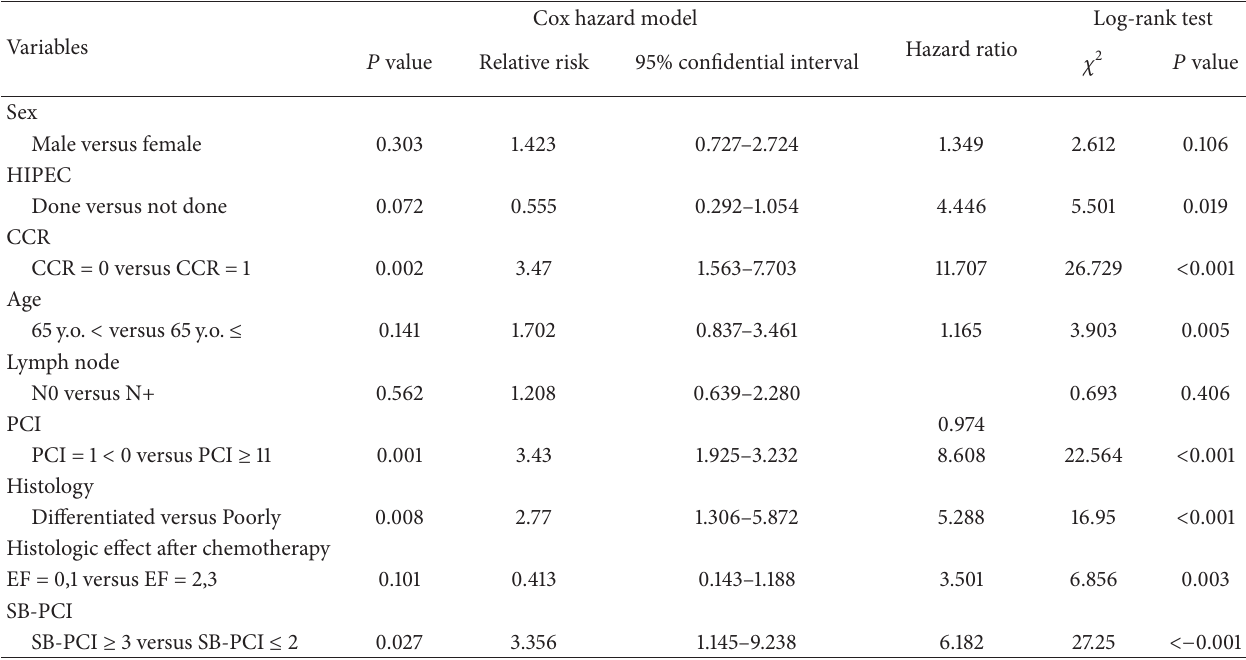
Table 3: Results of multivariate analyses and Log-rank test. The Cox multivariate analysis demonstrated CCR-0 ( 𝑃 = 0.002 ): histologic